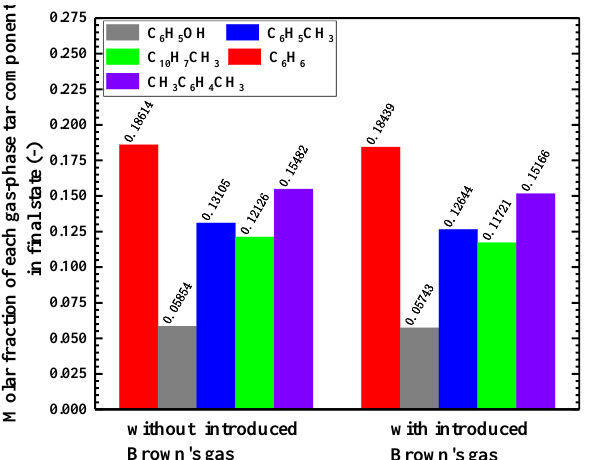
Figure 3. The molar fraction of each gas-phase tar component in the final state of reaction 3. Experi- ment research.